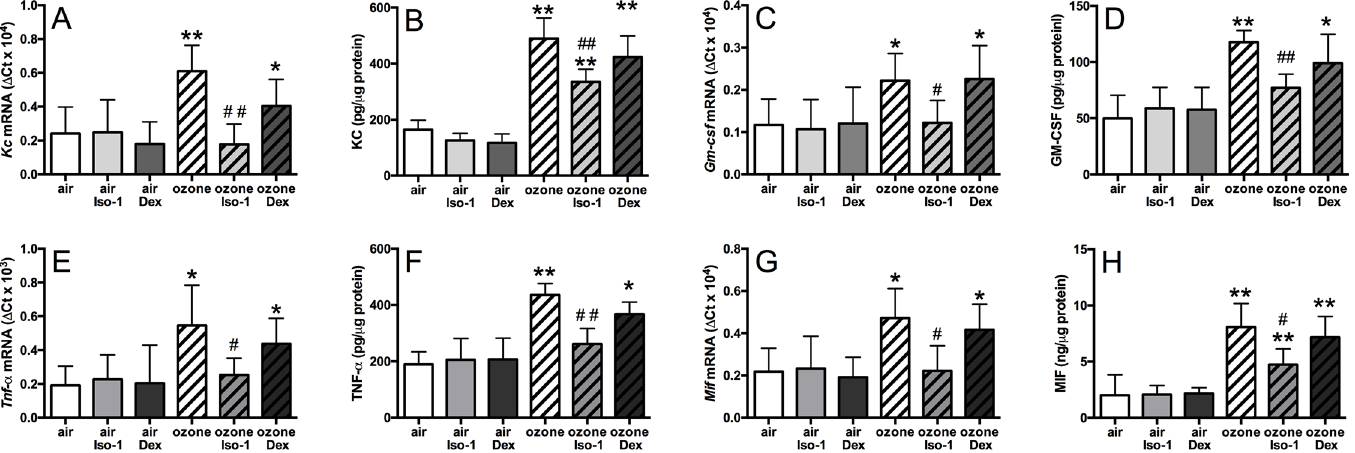
Fig 5. Effect of ISO-1 and dexamethasone on ozone-induced lung inflammation. Cytokine mRNA (A, C, E & G) and protein (B, D, F & H) expression levels in the lung of ozone exposed and ISO-1- or dexamethasone-treated mice. KC (A&B), GM-CSF (C&D), TNF- α (E&F), and MIF (G&H). Data are expressed as mean ± SD for 6 animals per group. * p < 0.05 and ** p < 0.01 compared to air controls, # p < 0.05 compared to ozone exposed group.